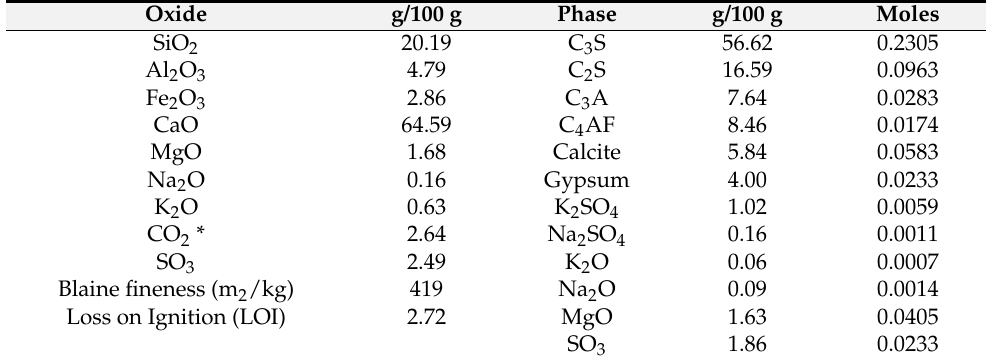
Table 1. CEM I (42.5N) oxide proportions (g/100 g) and normalised clinker